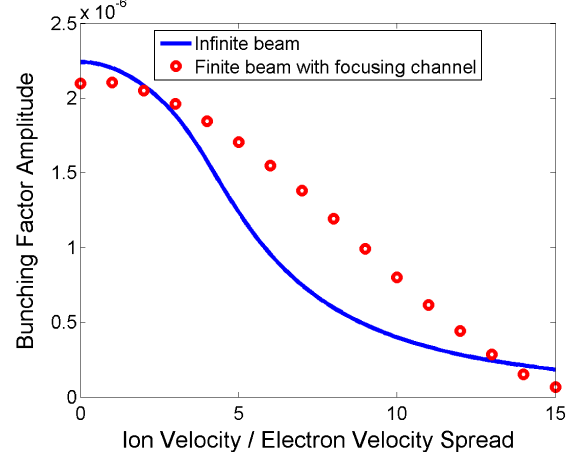
FIG. 17. Dependence of the bunching factor amplitude on the ion velocity at the end of the CeC modulator, electron velocity spread is fixed at 1e-3 and is used as a normalization